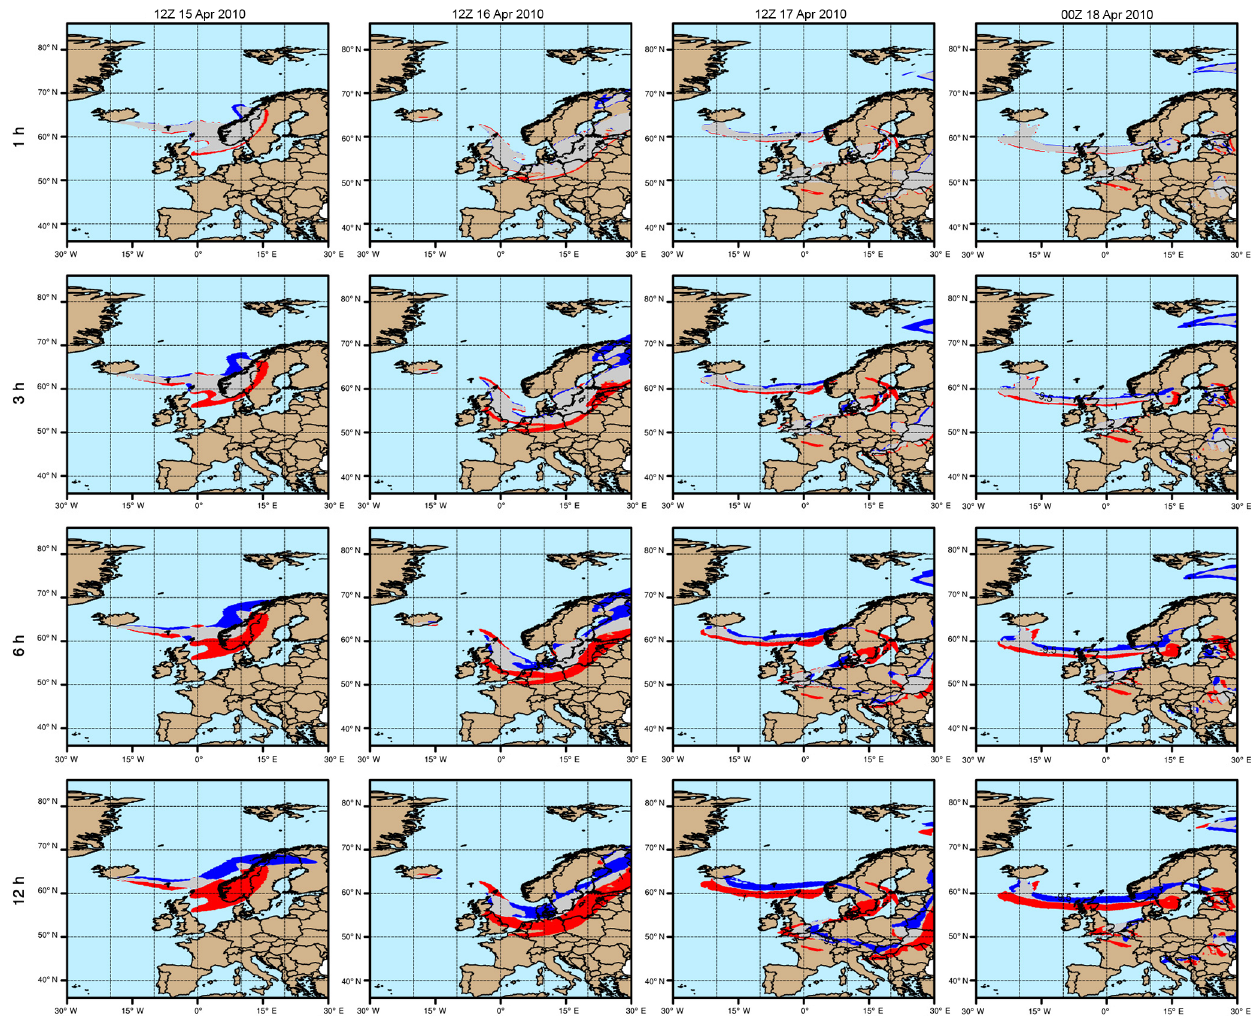
Figure 8. Qualitative comparison between the online and offline forecasts with 1h (row 1), 3h (row 2), 6h (row 3), and 12h (row 4) coupling intervals. Gridded evaluation is performed following the criteria presented in the contingency Table 1. Hit (grey), missed (red), and false alarm (blue) predictions are shown for the 2010 Eyjafjallajökull case over time. Table 4. Evaluation scores for the 2010 Eyjafjallajökull eruption application at the end of the 48h forecast with